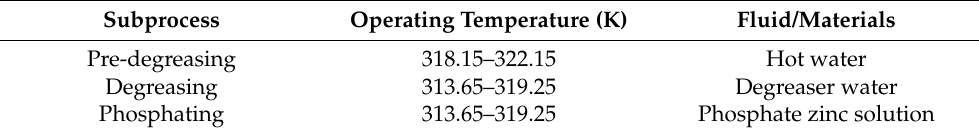
Table 1. Operating conditions in the pretreatment process, adapted from [17].